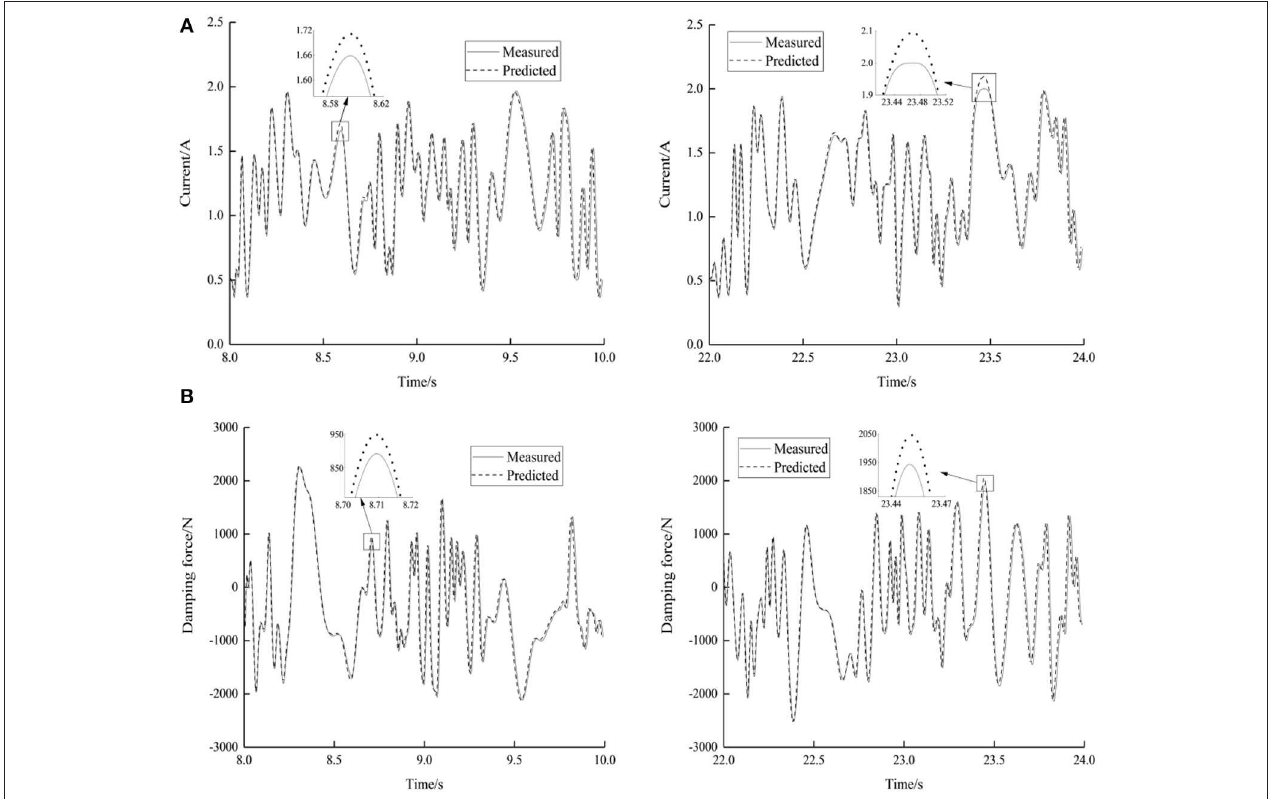
FIGURE 14 | Error distribution of the original and optimal inverse model.